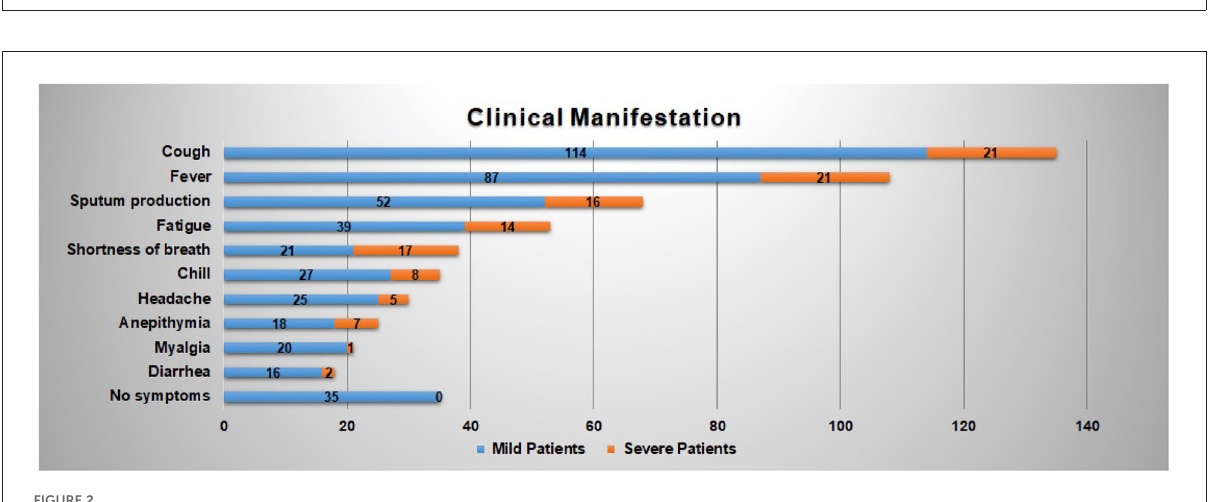
Softmax The softmax multi-class classifier; L cross-entropy The cross-entropy loss